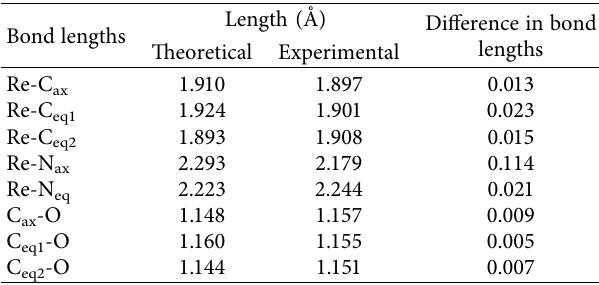
Table 2: Dihedral angles of some connections in ReABT (theo- retical) and ReAPBT (experimental).